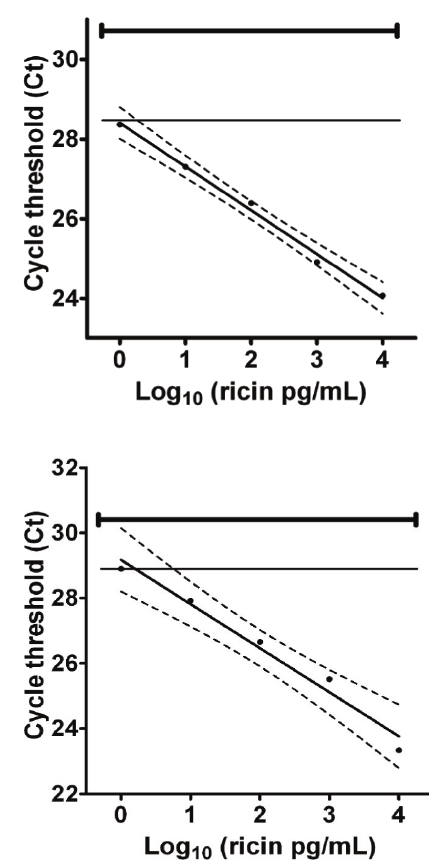
Figure 2. Standard curves for IPCR detection of ricin in sera and feces. Ct values were plotted against log ricin concentrations (pg/ mL) for three replicate samples in mouse sera (A) and feces (B). The linear regression of the calibration curve has a correlation coefficient of r 2 =0.99. The dashed lines are the upper and lower 95% confidence limits. The solid horizontal thick line denotes the average blank Ct value, with the standard deviation drawn at each end of this line. The solid horizontal thin line intersecting the linear regression line indicates the detection threshold of the IPCR assay as defined in the text. doi:10.1371/journal.pone.0012858.g002 10,000 pg/mL, the recovery from serum was at least 98.2%, and recovery from feces was at least 89.7%. The detection sensitivities of the IPCR assays for ricin in mouse sera and feces were compared with a standard ELISA method (Table 3). The detection threshold for ricin in mouse sera and feces by sandwich ELISA was about 10 ng/mL; about 4 orders of magnitude less than the 1 pg/mL sensitivity of the IPCR method. Table 2. Percent (%) recovery of ricin from mouse sera and feces.